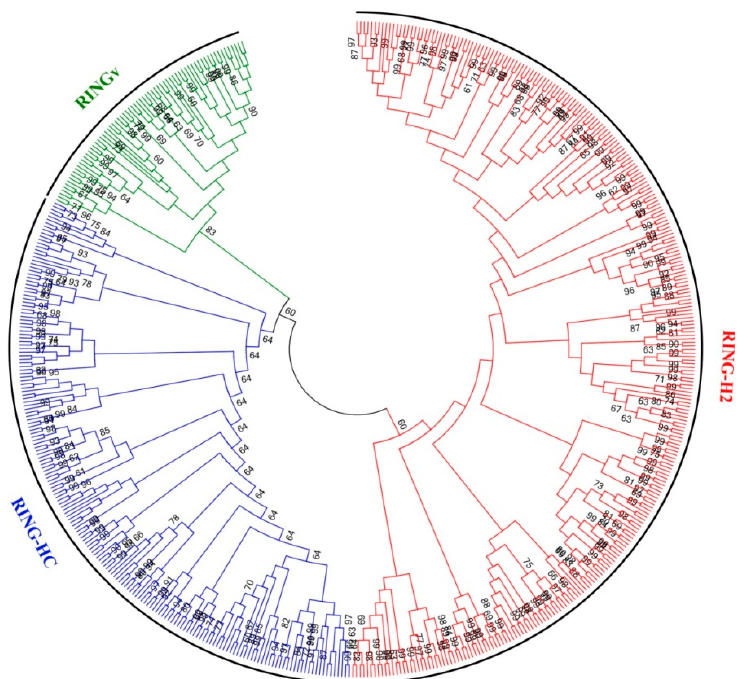
Figure 1. Phylogenetic relationship of the RING domains from 540 RING proteins in Populus trichocarpa . A phylogenic tree was constructed by MEGA 6.06 using the neighbor-joining method with 1000 bootstrap replicates. The red, blue and green represented RING-H2, RING-HC and RINGv, respectively.